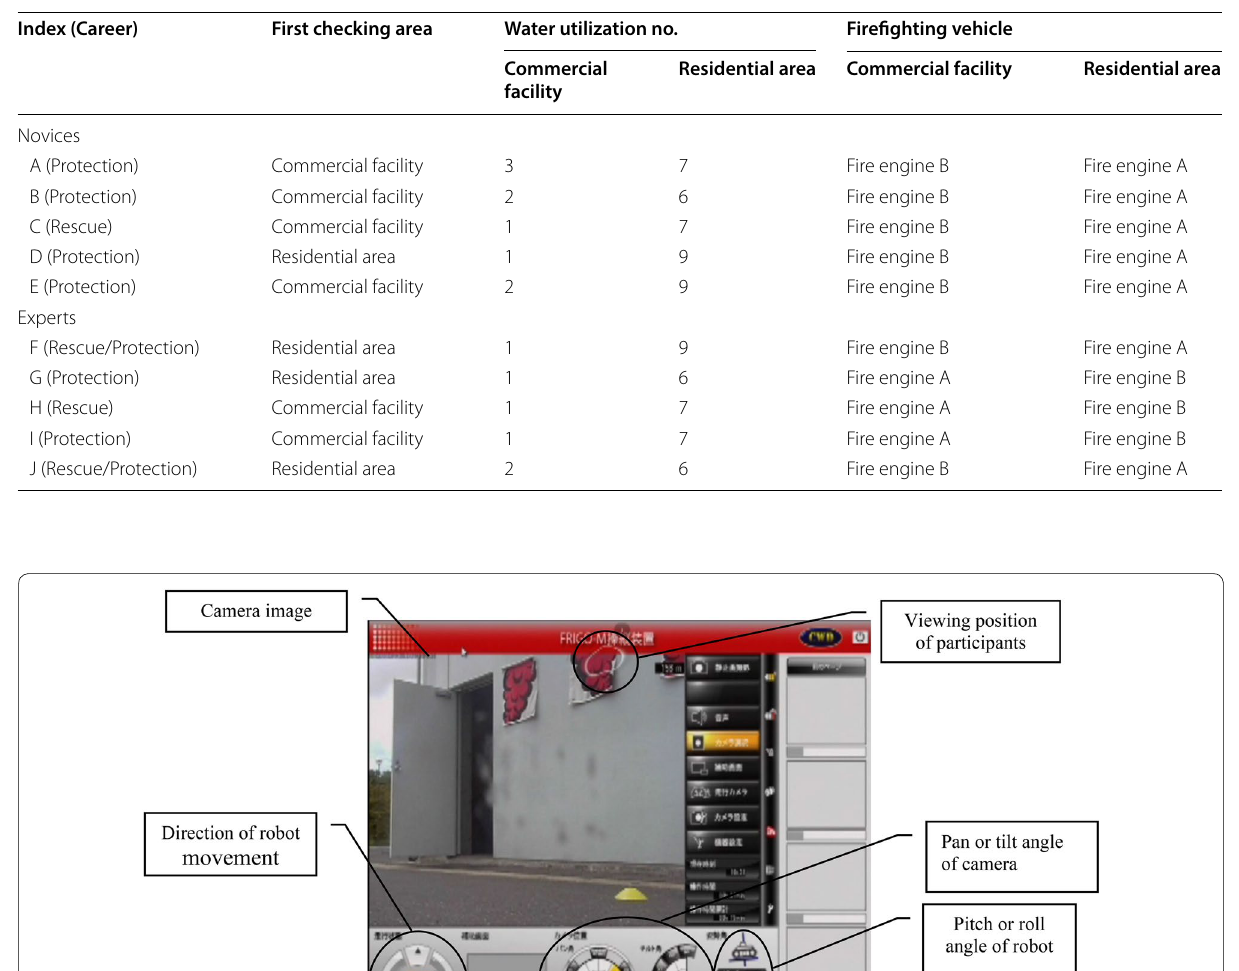
Table 7 Results from participants’ recording sheets